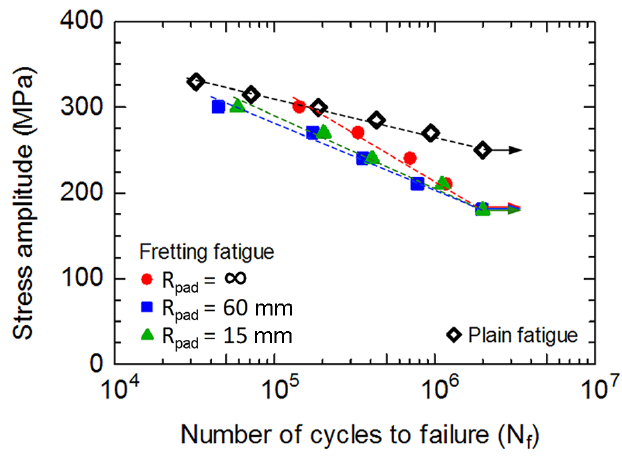
Figure 2. Stress amplitude versus fatigue life.